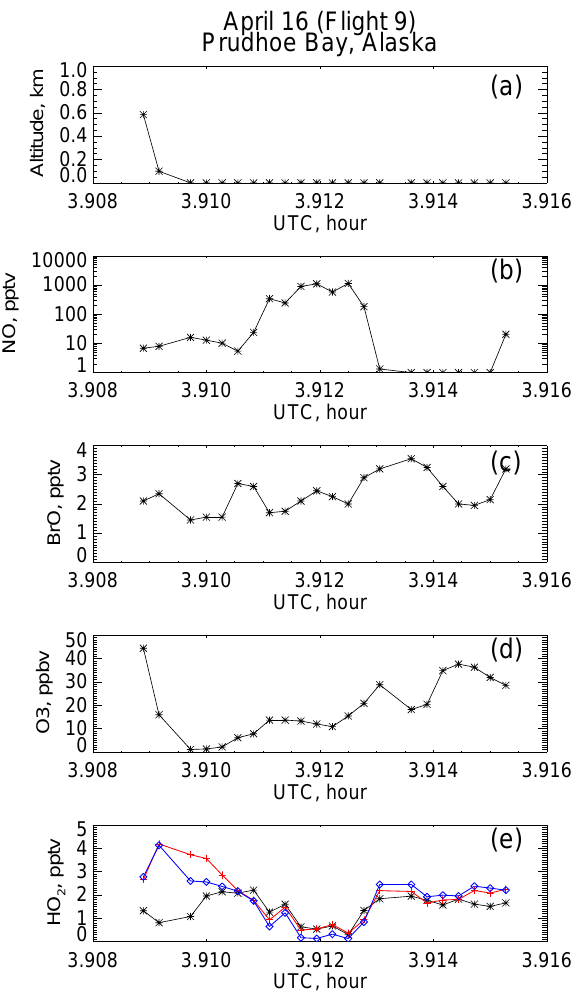
Fig. 14. Case study for impact of bromine on 16 April. Observed time series are shown for (a) Altitude, (b) NO, (c) BrO, and (d) O 3 . Observations of HO 2 are shown in panel (e) along with model predictions of HO 2 with and without BrO